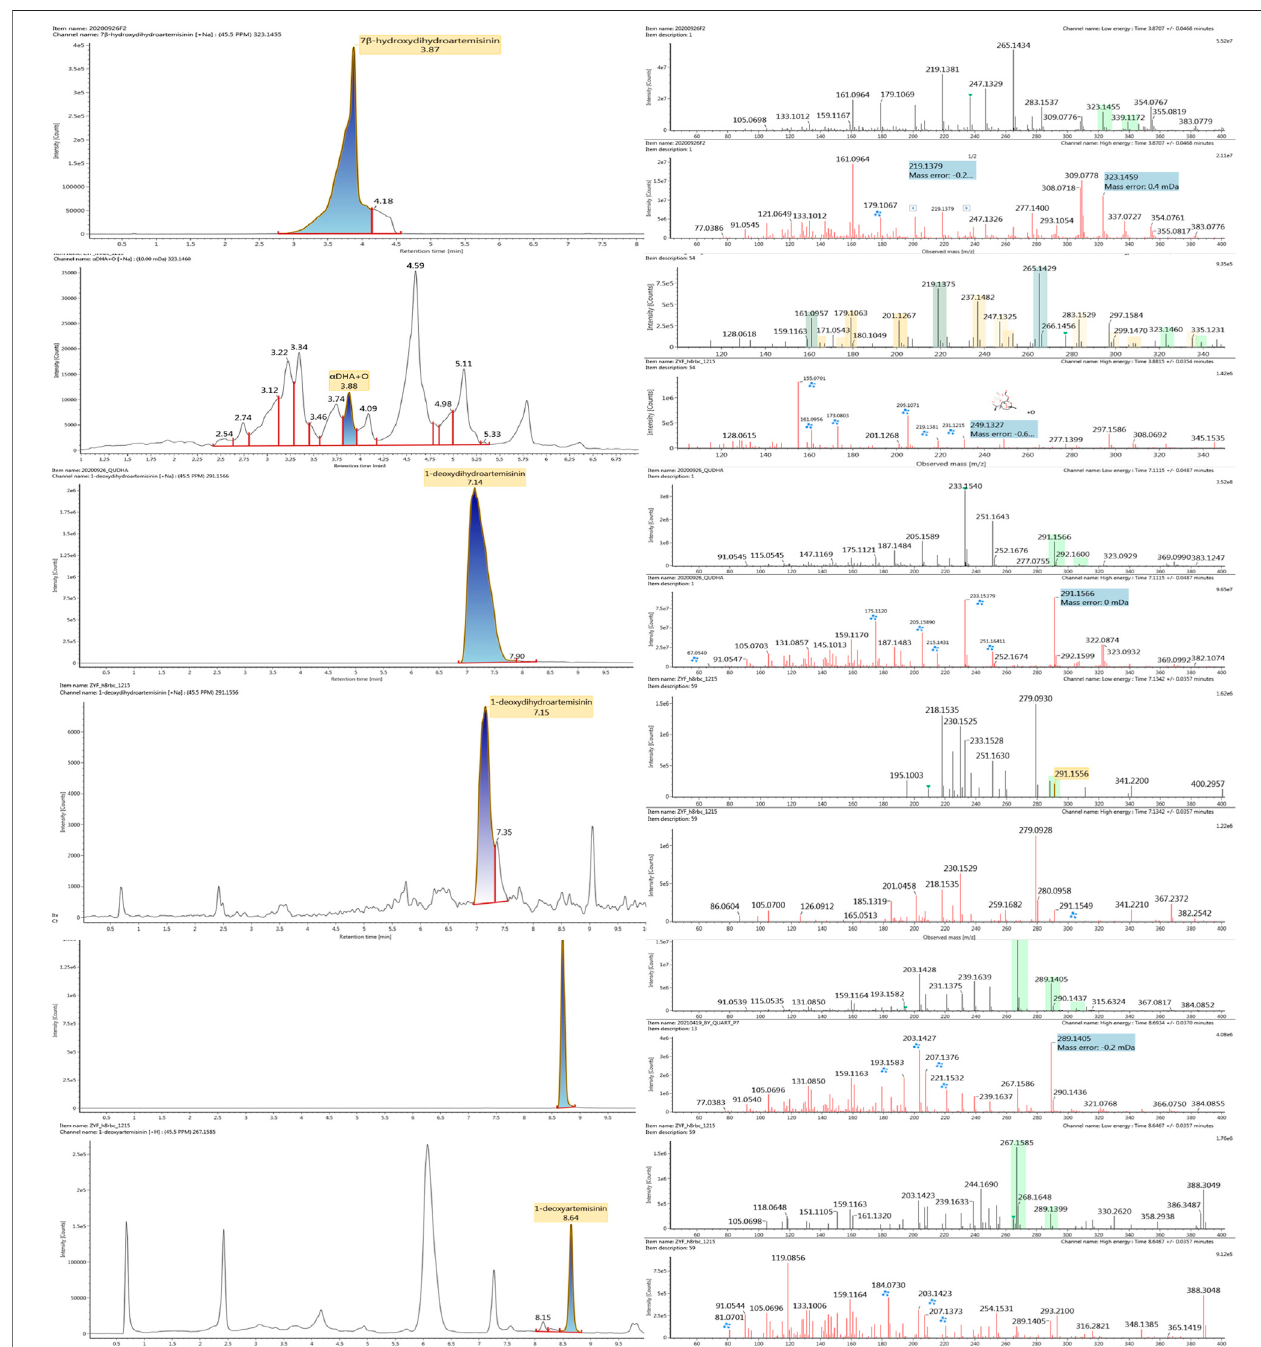
FIGURE 11 | Extracted ion chromatograms and mass spectrometry (MS E ) spectra of products M1 , M8 , and M9 and the metabolites of DHA in red blood cells.